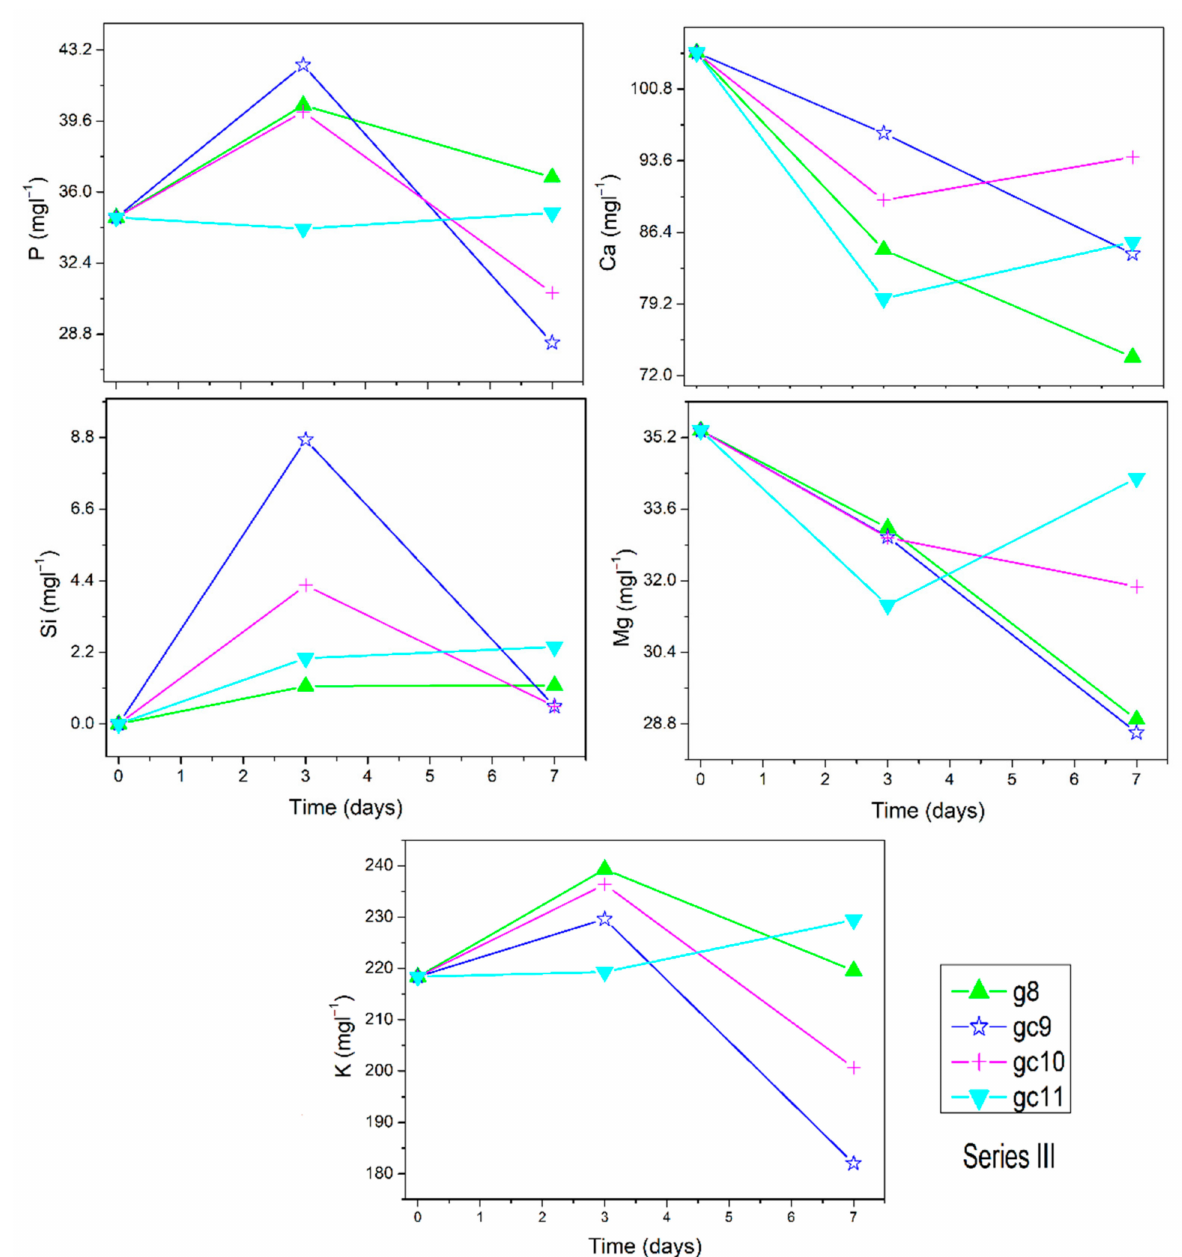
Figure 4. Ion dissolution profiles of series III samples in SBF under static conditions as function of immersion time. Error bars are included in the points’